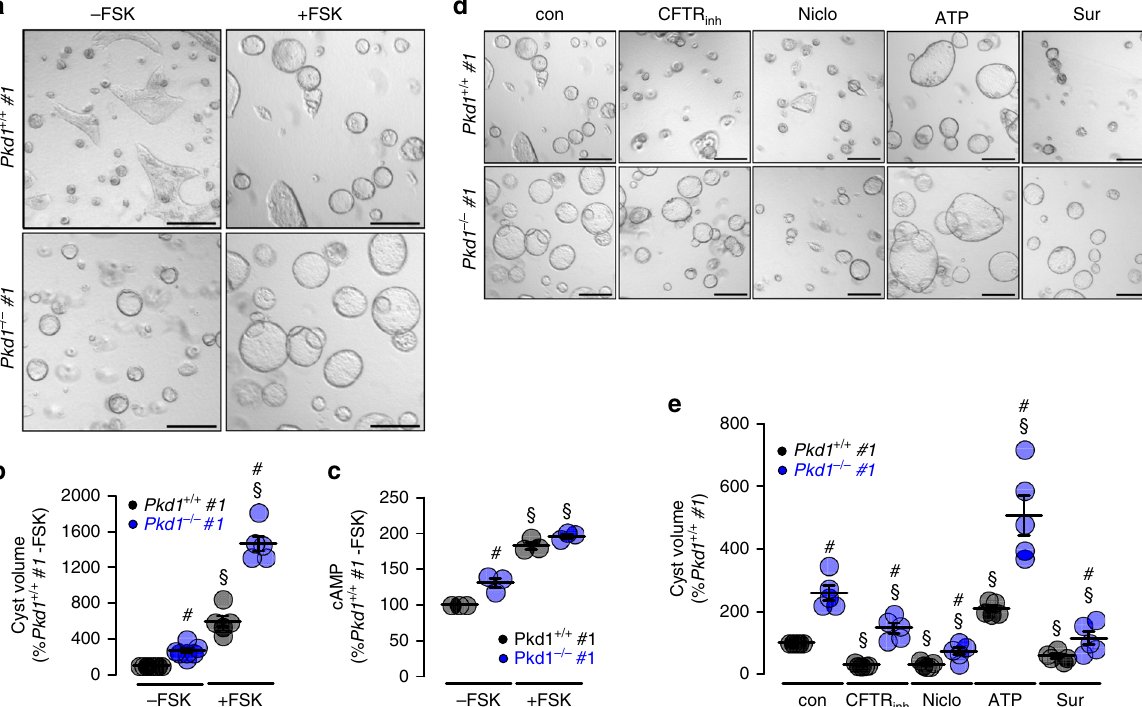
Fig. 1 Cyst formation by Polycystin-1-de fi cient cells depends on cAMP- and Ca 2 + -activated Cl − secretion. a , b Wild type ( Pkd1 + / + ) and polycystin-1- de fi cient ( Pkd1 − / − ) principal-like MDCK cells (clones #1) were cultured in a collagen matrix in the absence ( − FSK) or presence ( − FSK) of 10 µ M forskolin. Forskolin induced cyst formation by PKD1 + / + cells within 5 days ( § P < 0.0001). Pkd1 − / − cells demonstrated cyst formation even in the absence of FSK ( # P < 0.0001) and formed larger cysts in the presence of FSK ( # P < 0.0001) ( n = 105 cysts examined in n = 3 independent experiments). c Deletion of Polycystin-1 in Pkd1 − / − cells induced an increase in basal intracellular cAMP concentrations ( − FSK, # P = 0.041). FSK-stimulation further enhanced cAMP levels in both Pkd1 + / + and Pkd1 − / − cells ( § P = 0.0008) (each n = 3 independent experiments). cAMP levels in Pkd1 + / + cells were set to 100%). d , e Cyst growth was strongly inhibited in both Pkd1 + / + and Pkd1 − / − cells by CFTRinh172 (CFTRinh; 10 µ M, § P < 0.0001), niclosamide (Niclo; 1 µ M, § P = 0.0001), and suramin (Sur; 100 µ M, § P = 0.002), but was further augmented by ATP (10 µ M, § P = 0.002). Bars 200 μ m ( n = 87 cysts examined in n = 3 independent experiments). Mean and error bars indicating ±SEM. # Unpaired two-sided t test comparing Pkd1 + / + with Pkd1 − / − , § unpaired two-sided t test comparing effects by forskolin, ATP or inhibitors. Source data are provided as a Source Data fi